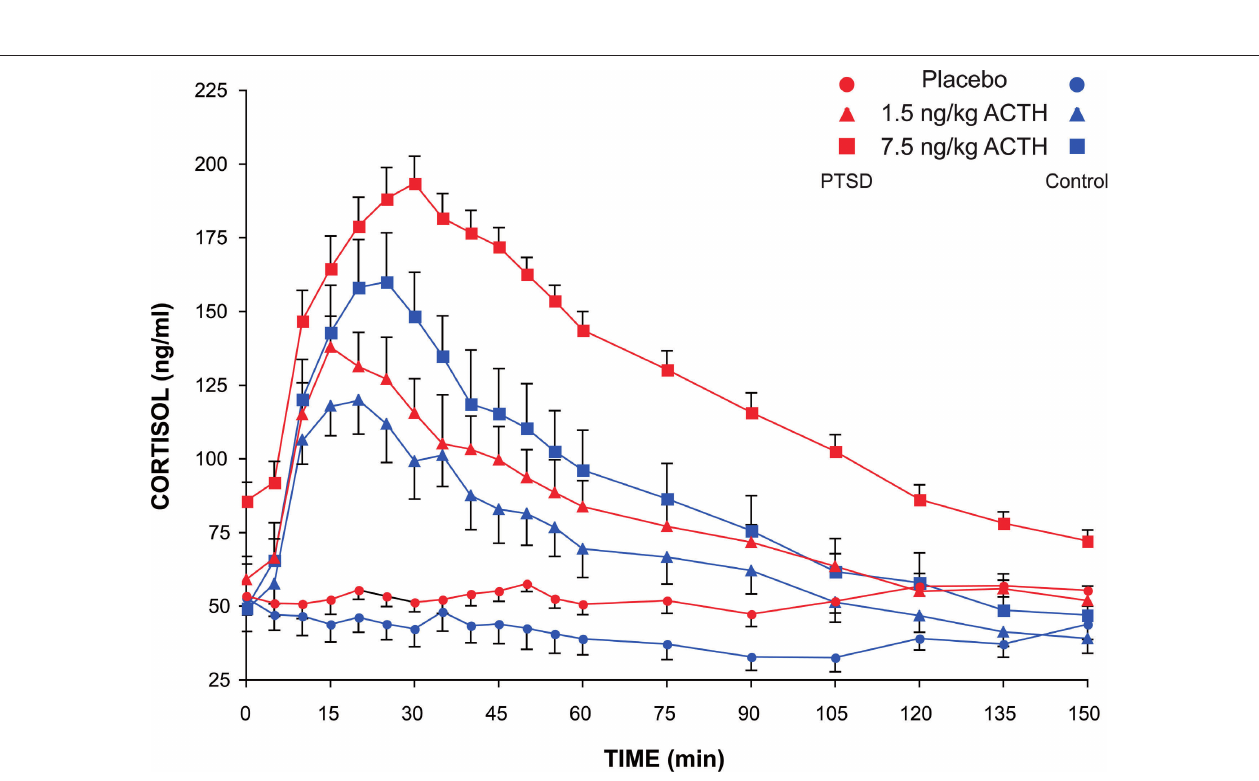
FIGURE 1 | Plasma ACTH concentration in PTSD and control subjects after ACTH infusion. Sampling occurred at 5-min intervals for 60 min and at 15-min intervals for the following 90 min. Mean and SEM values are plotted for each subject group and each dose of ACTH for the fi rst 45 min after infusion during the dynamic portion of the ACTH concentration profi le.